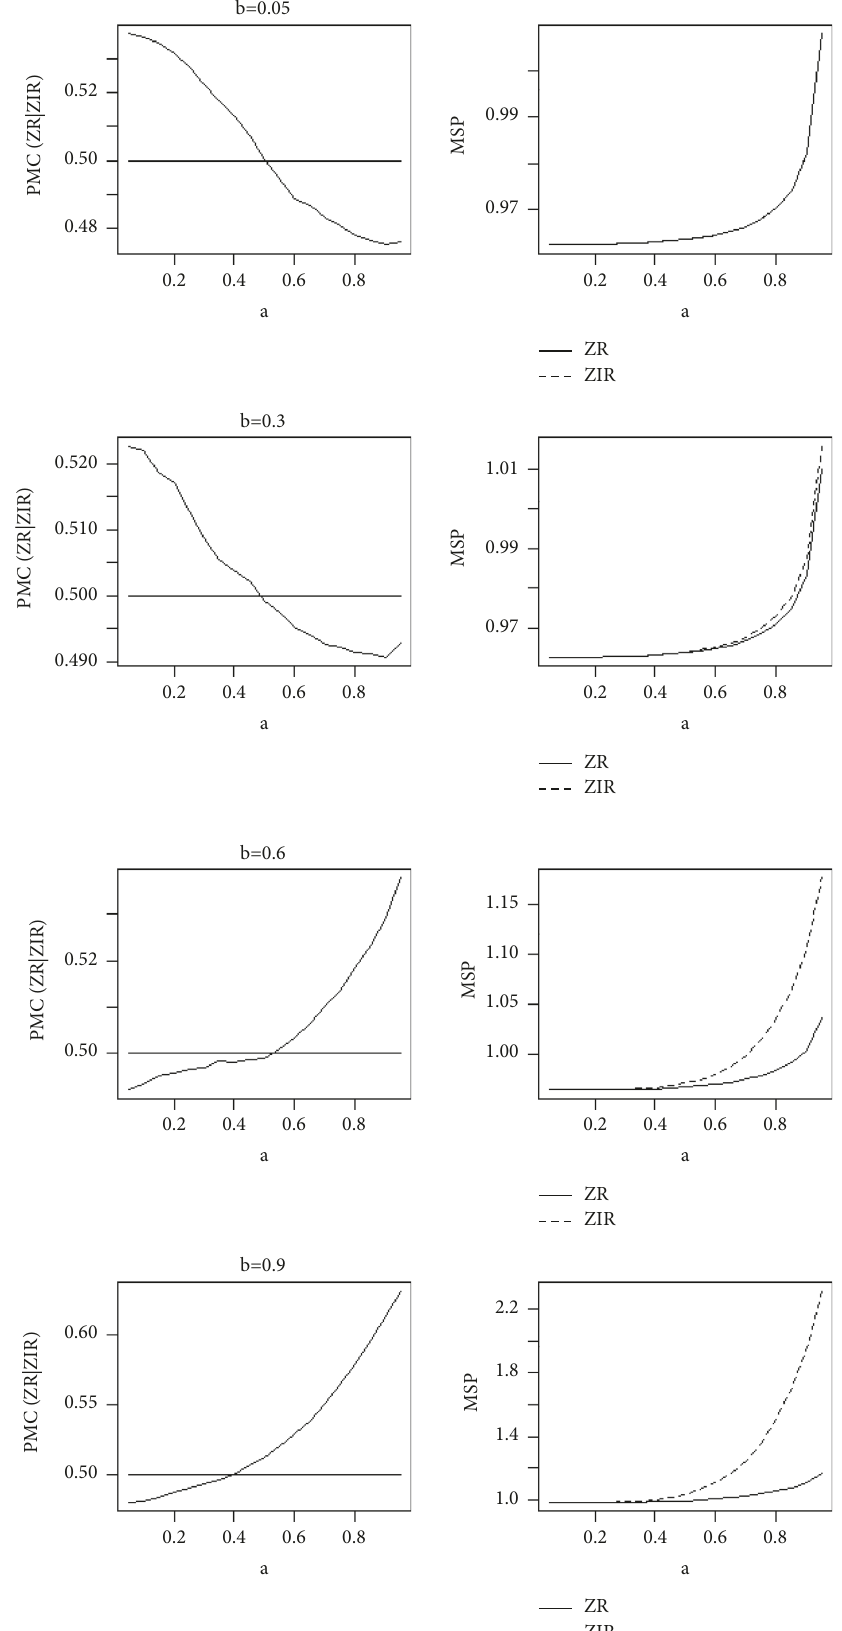
Figure 6: Comparison between 􏽢 Z R and 􏽢 Z R with exponential errors for some fixed a and all b